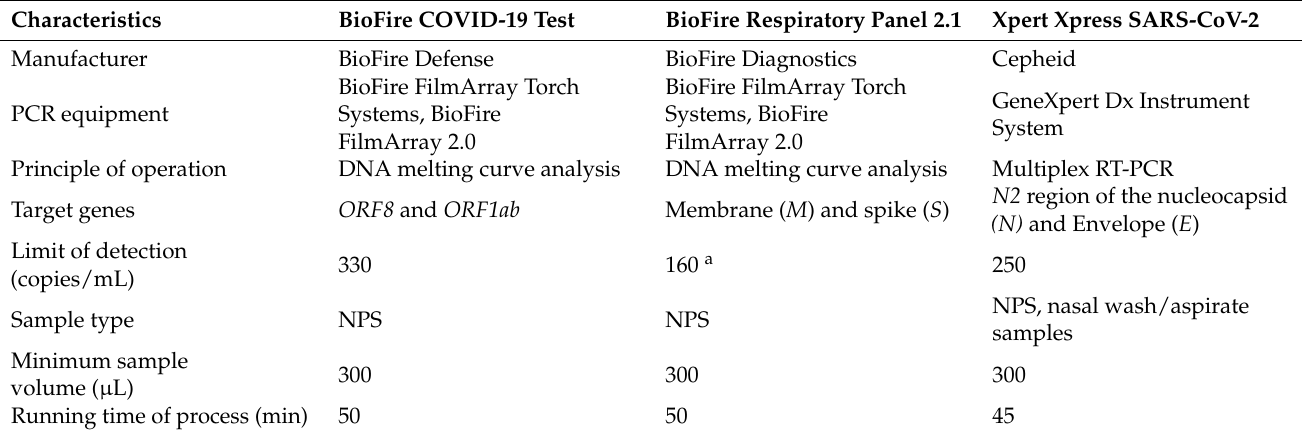
Table 1. Performance characteristic information of the three sample-to-answer SARS-CoV-2 reverse transcription PCR assays provided by the